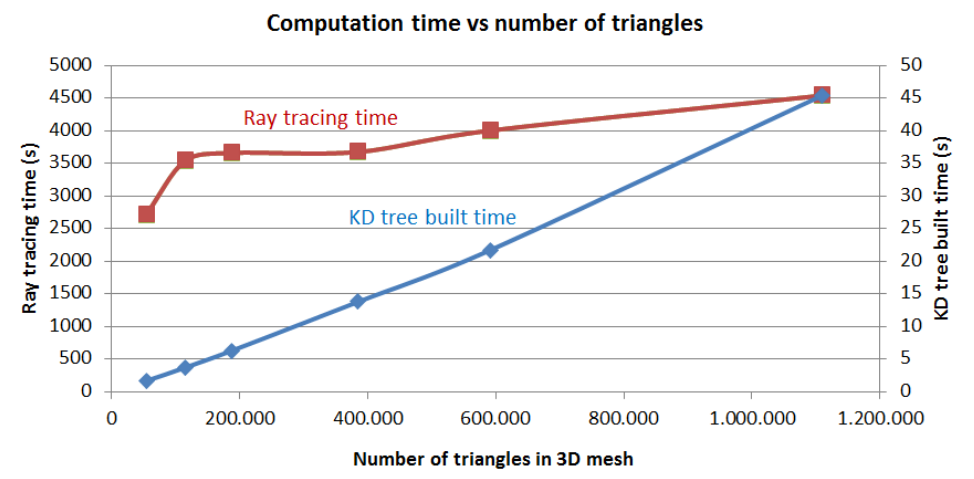
Figure 7. KD tree construction and ray tracing time with respect to the number of triangles in a 3D mesh